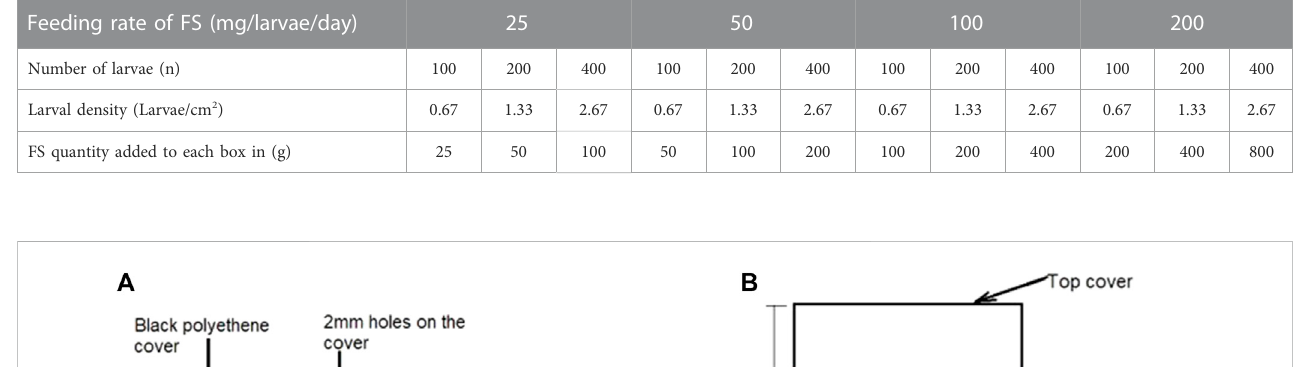
TABLE 1 Description of feeding rate and larval density used in experiment. Feeding rate of FS (mg/larvae/day)